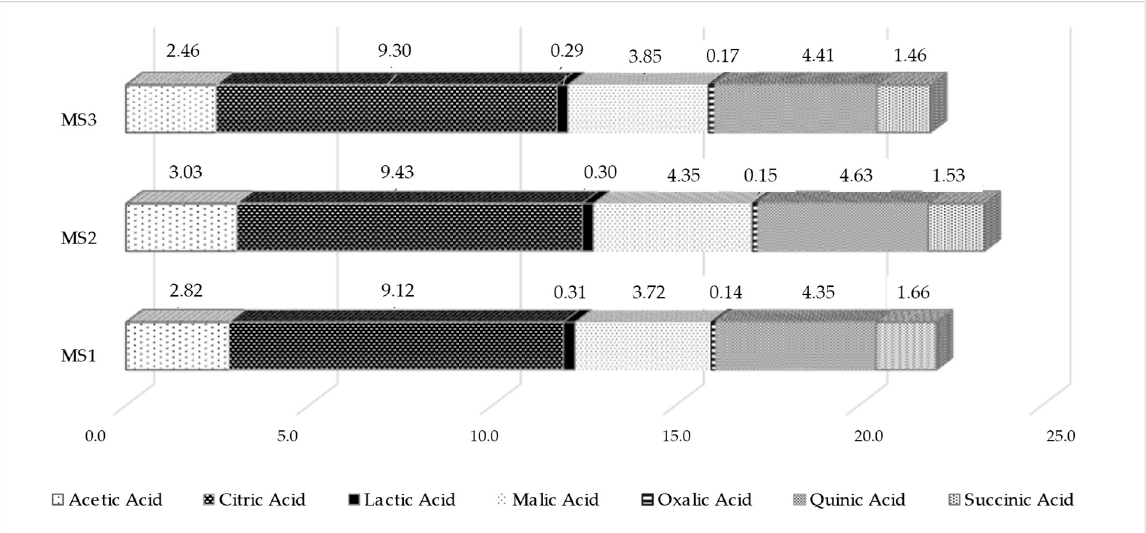
Figure 4. Average content (g/kg) of organic acids for three stages of maturity of coffee fruit.